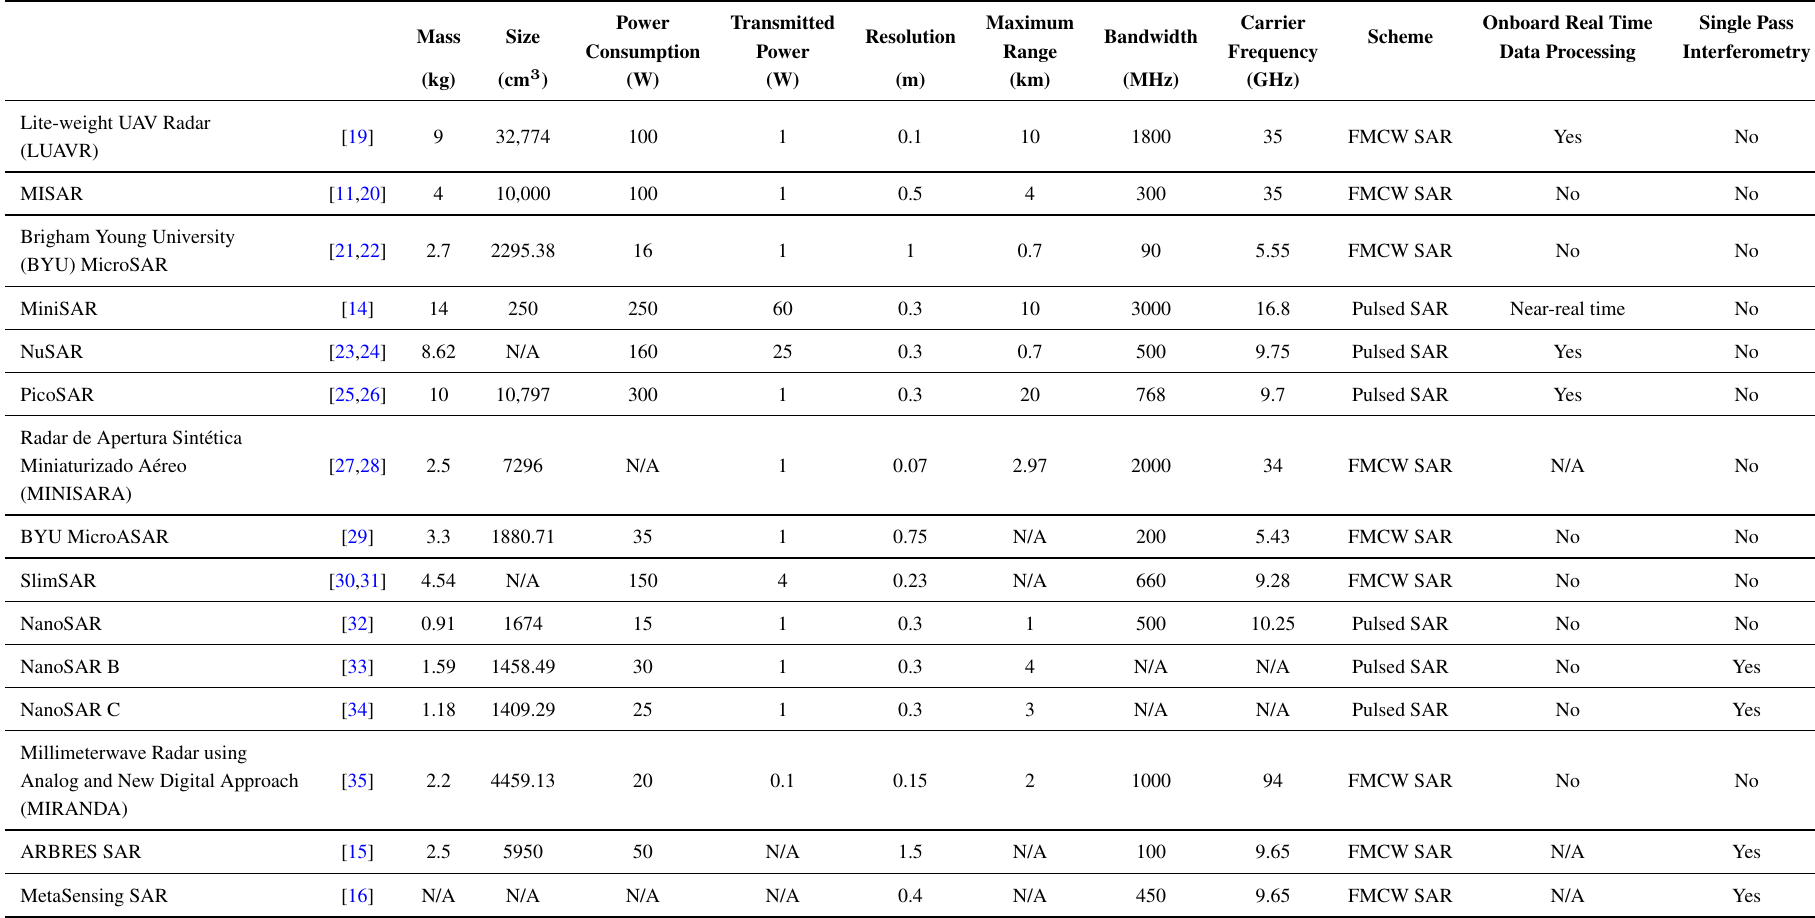
Table 2. The main features of existing compact lightweight SAR systems (N/A = not